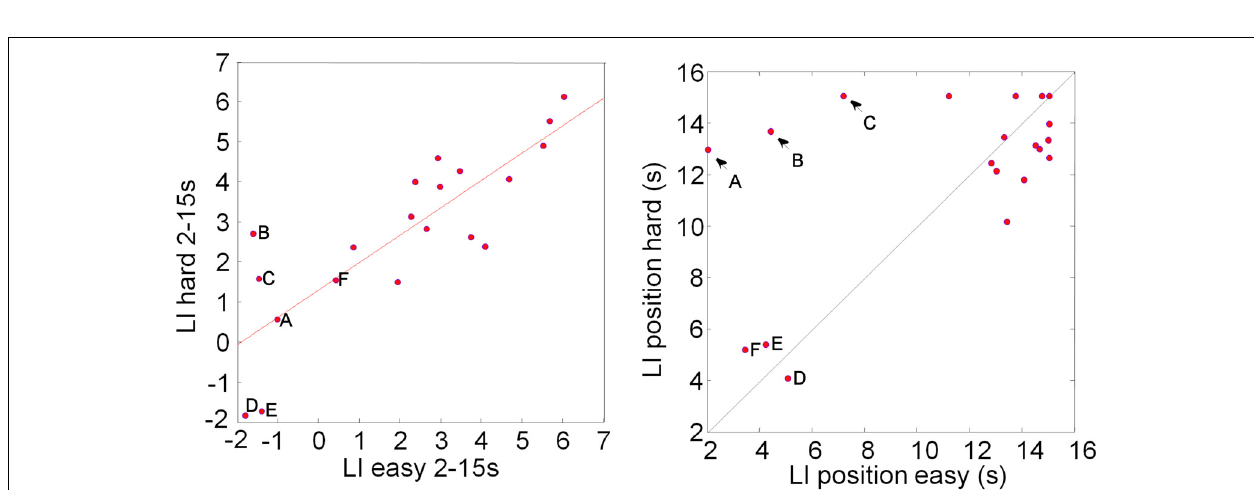
FIGURE 3 | Plot of Lateralization Indices (LI) computed for each participant in the easy and hard condition (left). The data show highly correlated ( r = 0 . 83, n = 20, p = < 0 . 0001) LIs. The LIs are computed by averaging the CBFV difference in a window, here 2s, around the absolute peak value in the analysis window, here 2–15s post task onset. This means that, when LIs for two conditions or tasks are compared, the peak values do not have to coincide. The right hand graph shows the position of the